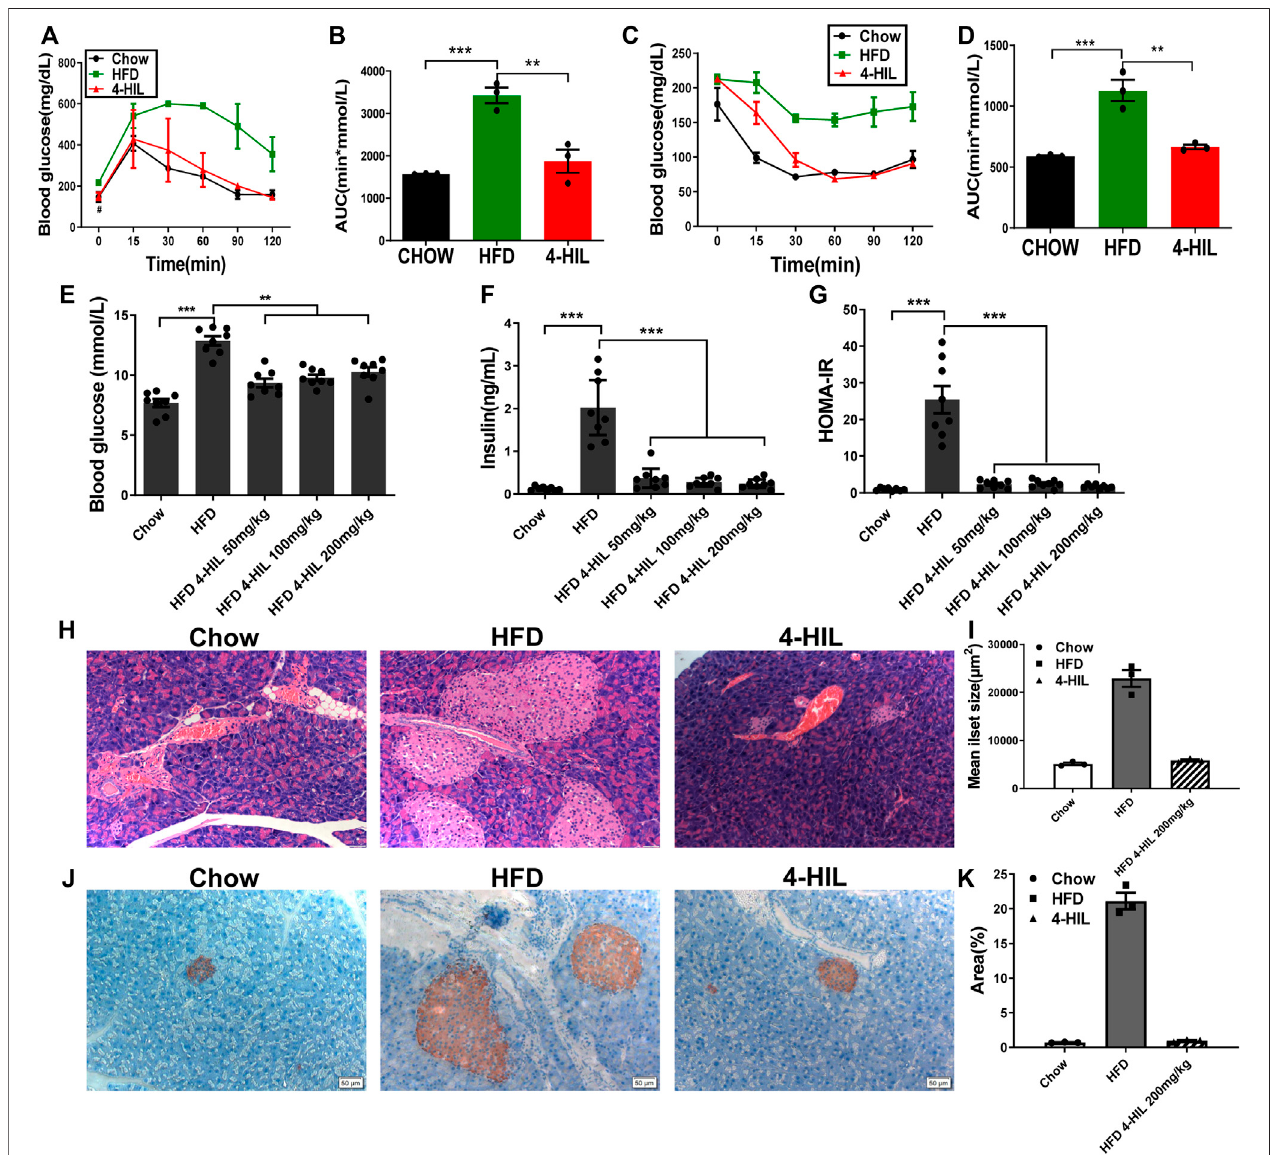
FIGURE 2 | 4-HIL improves insulin sensitivity. After 4-HIL administration, the mice in CHOW, HFD, and 4-HIL (200 mg/kg) were fasted for 8 h prior to glucose tolerancetest (A) andinsulintolerancetest (C) .Theareaunderthecurve (B) , (D) wascalculated.Afterfastingfor8 h,bloodsamplesofmiceweretakenfromthetailtipto measureblood glucose usingabloodglucosemeter (E) ,and theconcentration ofinsulininthesamplewasmeasuredbyELISA (F) .Theinsulinresistance index (G) was calculated according to the formula provided in the text. At the end of administration, the isolated pancreatic tissues of mice were used for HE staining (H) and insulinantibodyimmunohistochemicalstaining (J) .Themeanisletarea (I) andinsulinpositive (K) wereanalyzedandquanti fi edusingImageJsoftware.*,0.01 < p < 0.05; **, 0.001 < p < 0.01; ***, p < 0.001 ( n (cid:2) 8 for each group).